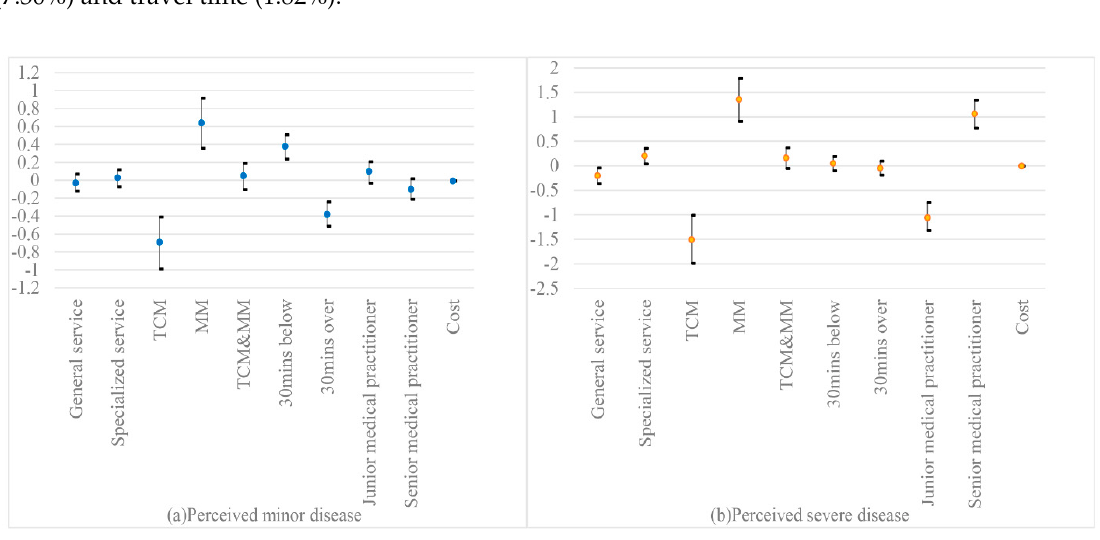
Figure 3. Relative importance of the attributes.